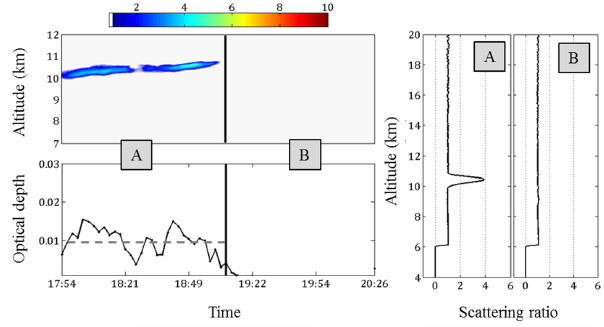
Figure 1. Data sampling method. On the left, the top panel represents the evolution of a cirrus cloud over time. The bottom panel corresponds to the optical thickness for the same period. For both panels the vertical black line shows when a significant change point in the optical thickness time series is detected, leading to the situation A (with cirrus cloud) and B (without cirrus cloud). The corresponding scattering ratio profiles for both situations, A and B, are illustrated on the right.